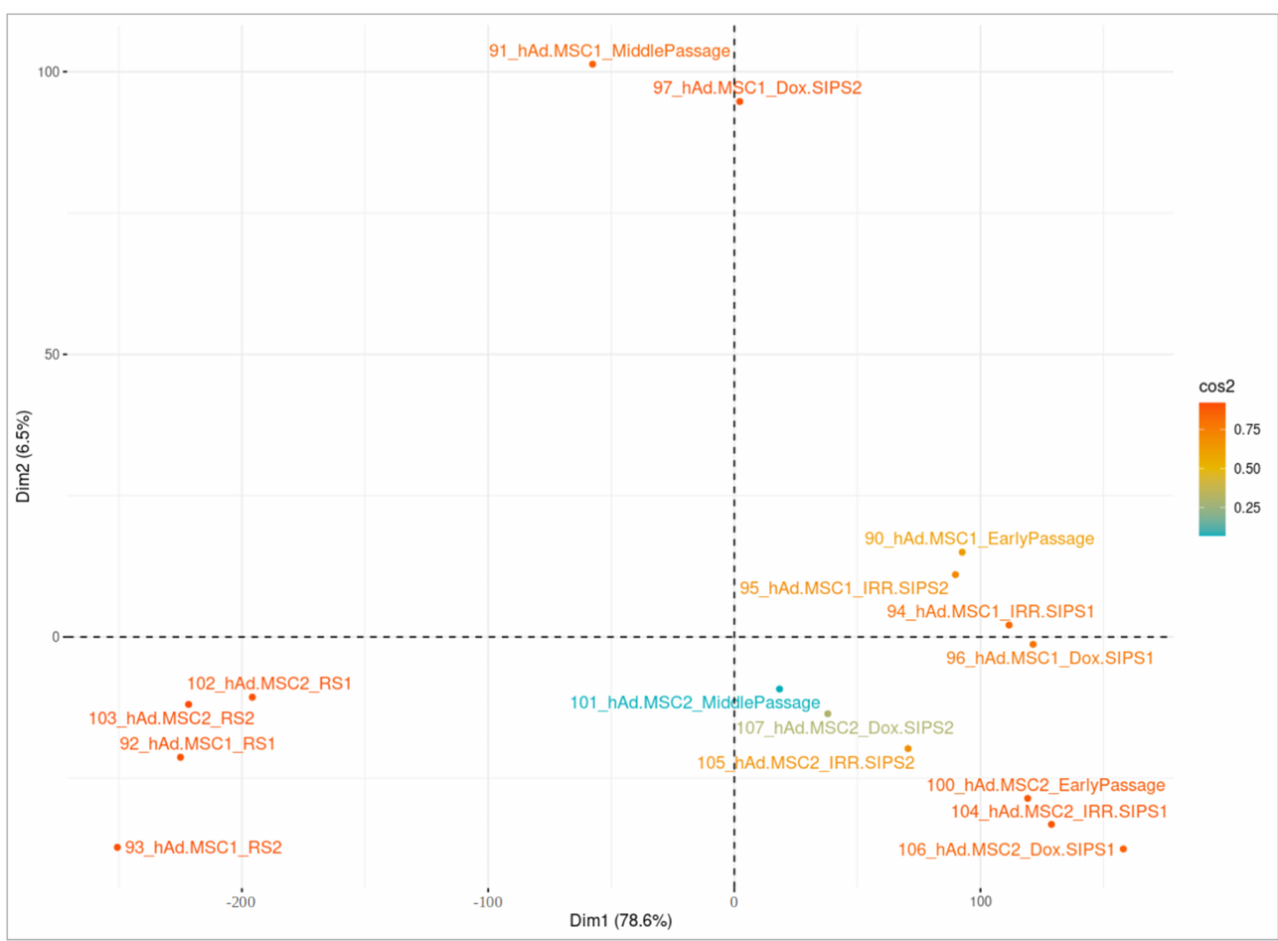
Figure 5. Visualization of cluster analysis in hAd-MSC samples. Principal component analysis (PCA) was performed on normalized β -values of unique differentially methylated positions in cells after a middle number of passages (MidPass), in replicative senescence (RS), in stress-induced premature senescence after exposure to ionizing irradiation (IRR-SIPS) and doxorubicin (Dox-SIPS). X-axis “Dim1” corresponds to the first principal component of PCA, and Y-axis “Dim2” to the second principal component. The percentage of total variability explained by the component is indicated in brackets. Colors reflect the quality of representation on the cluster map (cos2). Labels correspond to samples (for detailed explanation of sample identifiers, consult Figure